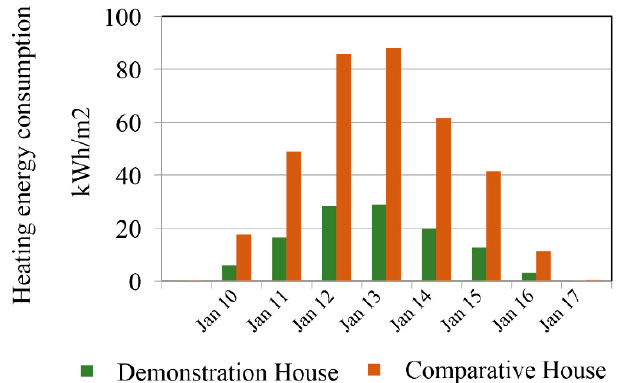
Figure 22. Monthly heating energy consumption per unit area of the two buildings in the Keshan area. Table 8. Heating energy consumption of the two buildings and energy savings rate in the three regions.